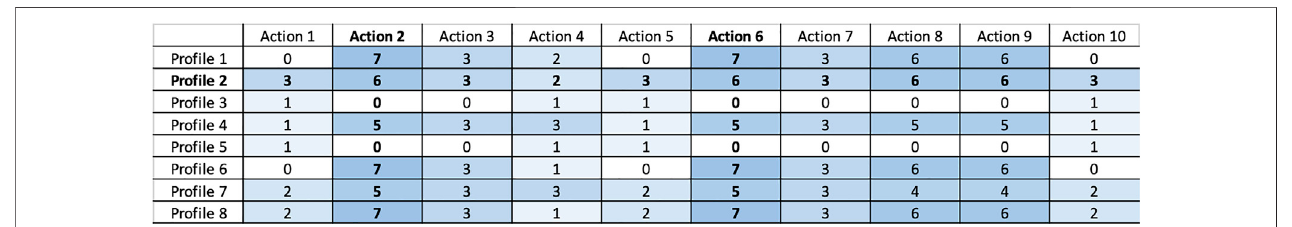
FIGURE5| Rankinginterventionactionsfordifferentpro fi les(actionenumeration:1)Denominationtest.2)Forwarddigittest.3)FreeandCuedSelectiveReminding Test. 4) Stroop test. 5) Animals test. 6) Backward digit span test. 7) Rey ’ s fi gure test. 8) Trailing Making Test form B. 9) Trailing Making Test form A. 10) Boston Naming Test 40-items.